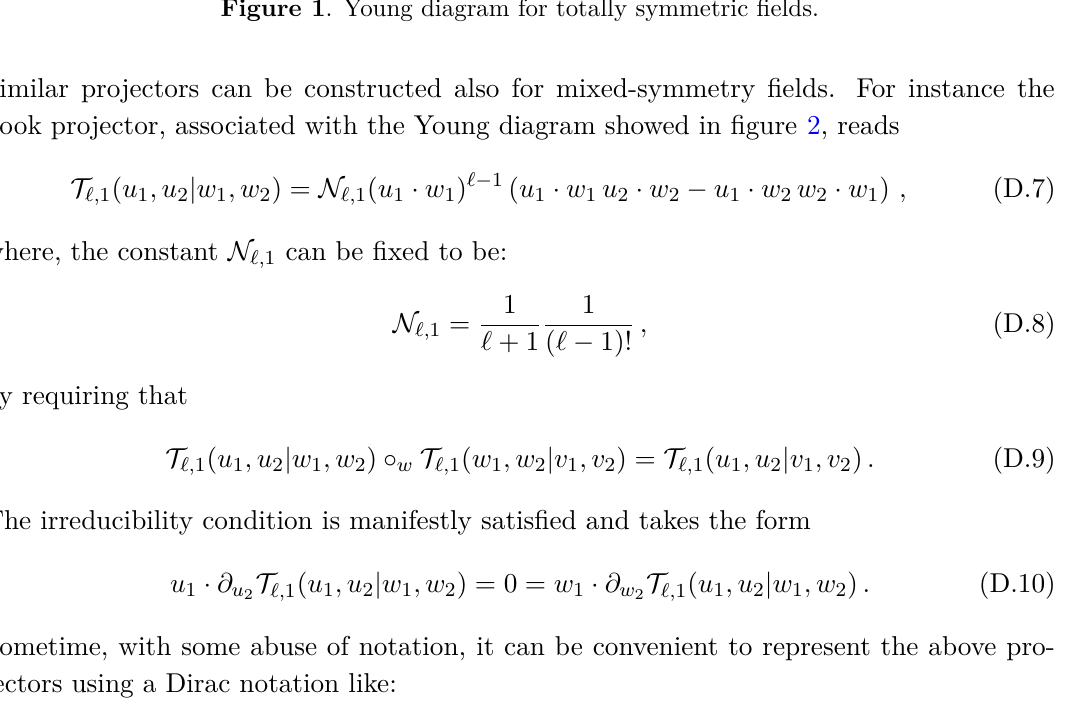
Figure 1 . Young diagram for totally symmetric